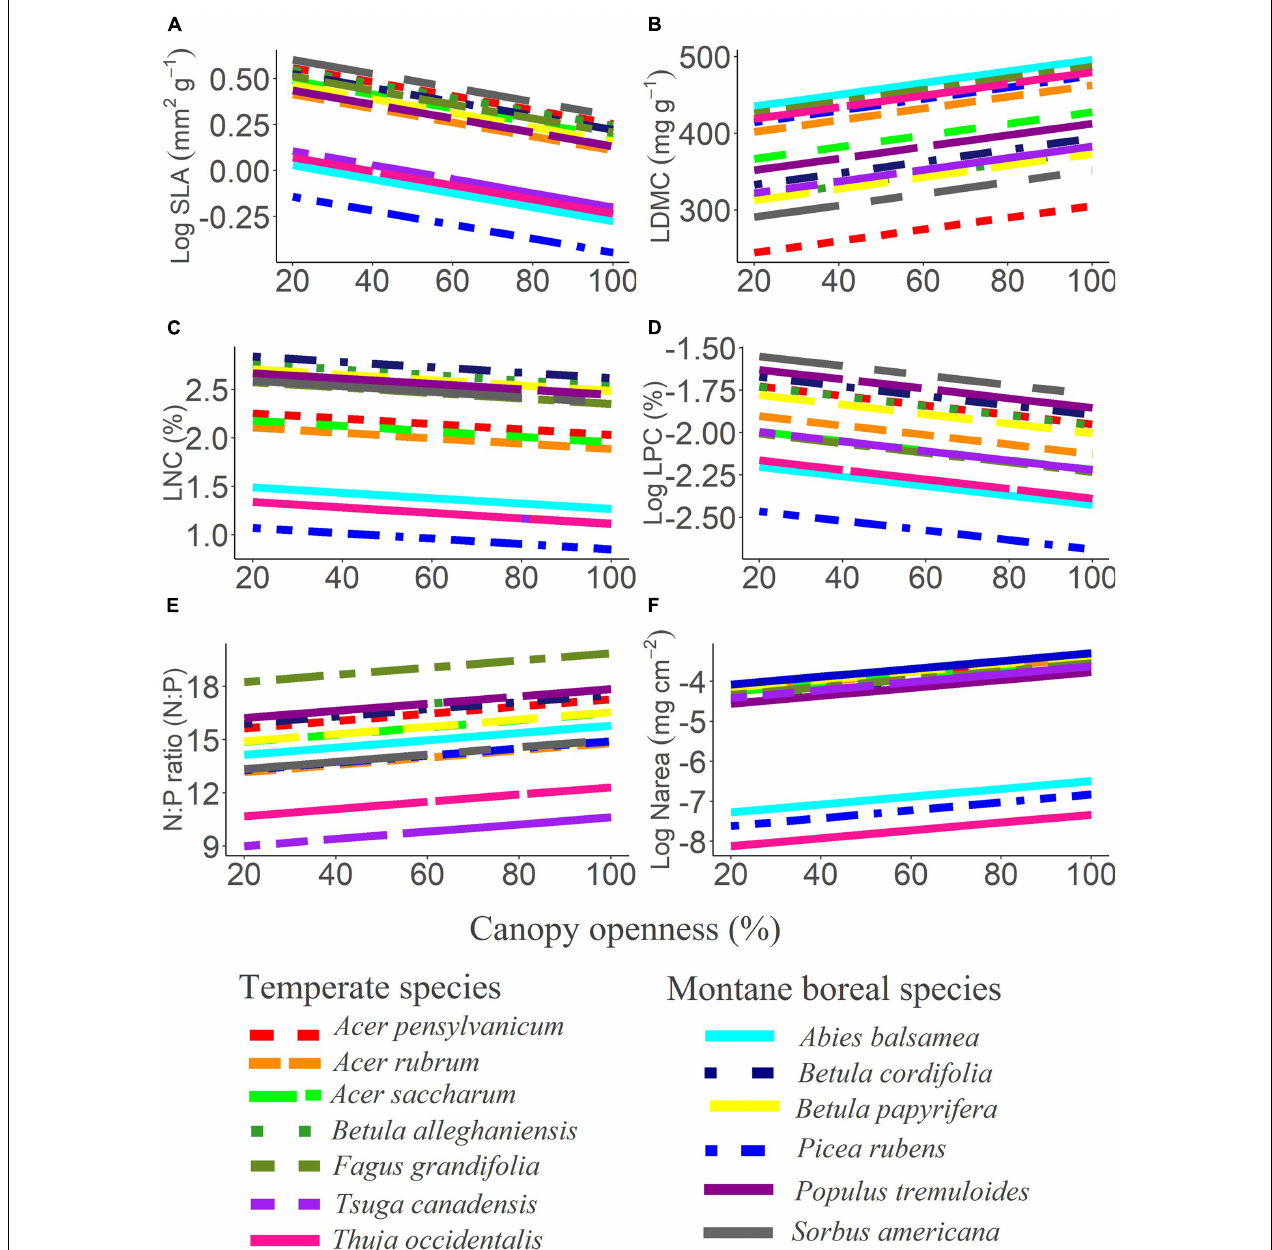
FIGURE 4 | Estimated relationships of measured functional traits to gradients of light. Lines show model estimates for each species from the best-fit model for (A) specific leaf area (SLA), (B) leaf dry matter content (LDMC), (C) leaf nitrogen concentration (LNC), (D) leaf phosphorous concentration (LPC), (E) nitrogen to phosphorous ratios (N:P ratio), and (F) leaf nitrogen per unit area